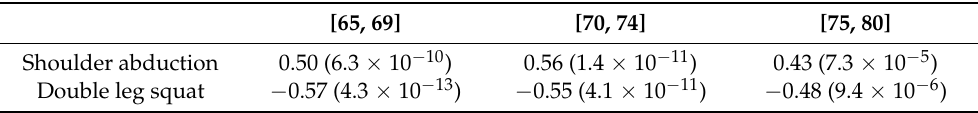
Table 6. Spearman’s rank correlation coefficients ( p -values) to assess statistical dependence between the rankings of survey responses and physical achievements by age range.